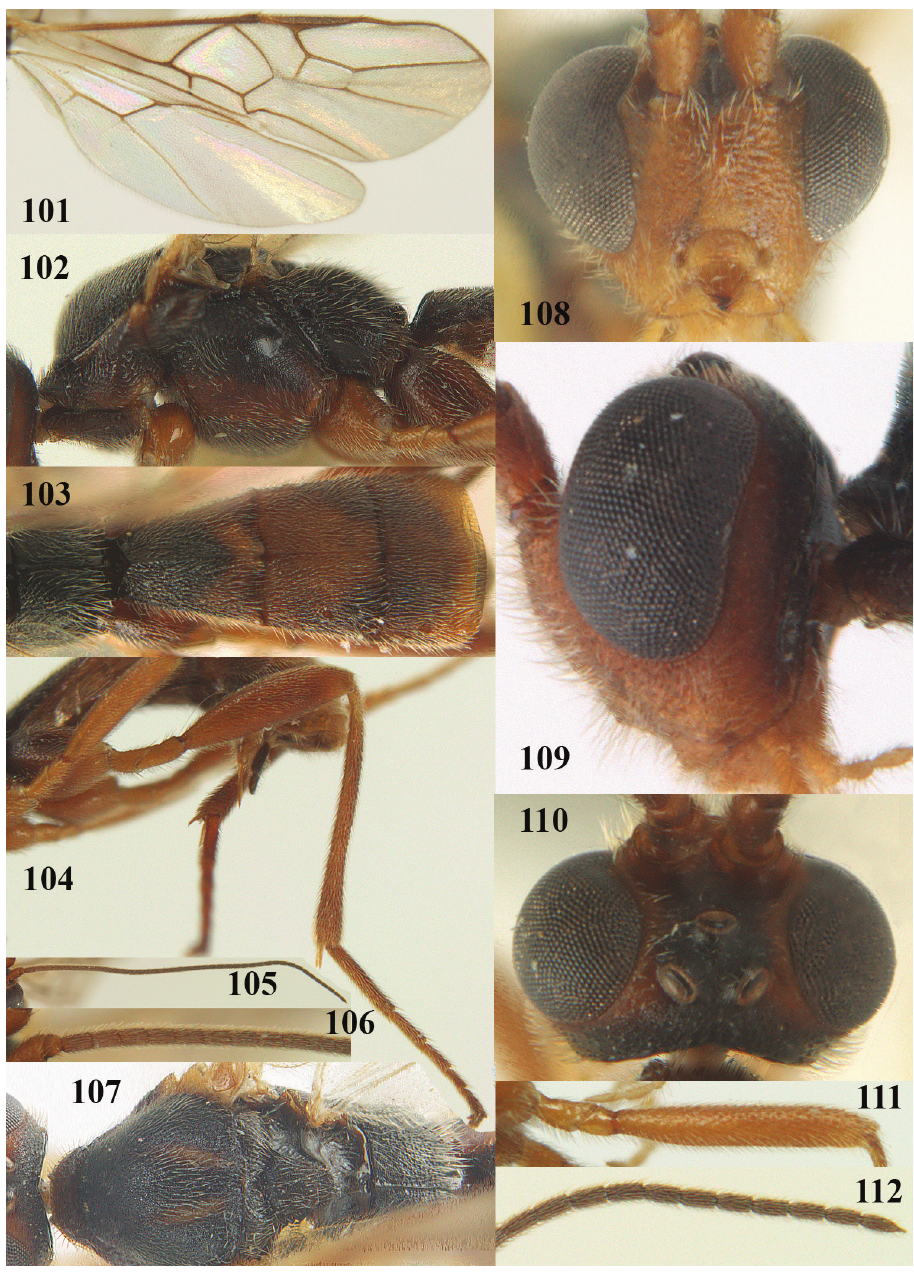
deum and metasoma dorsal 104 hind leg lateral 105 antenna 106 basal segments of antenna 107 meso- soma dorsal 108 head anterior 109 head lateral 110 head dorsal 111 fore femur lateral 112 apical segments of